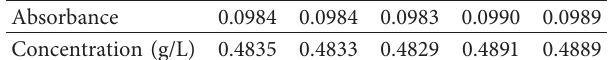
Table 4: Absorbance and concentration of same egg white tested by a traditional spectrophotometer.